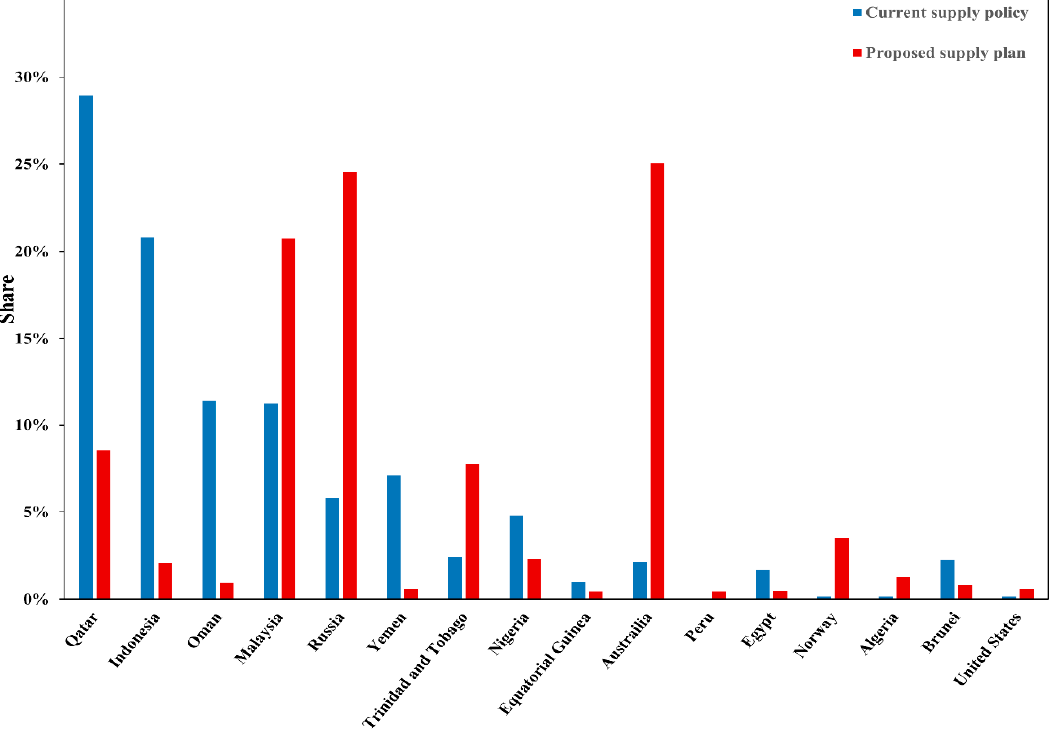
Figure 4. Comparison of portfolio analysis results. Table 9. Comparison of portfolio analysis results (%).